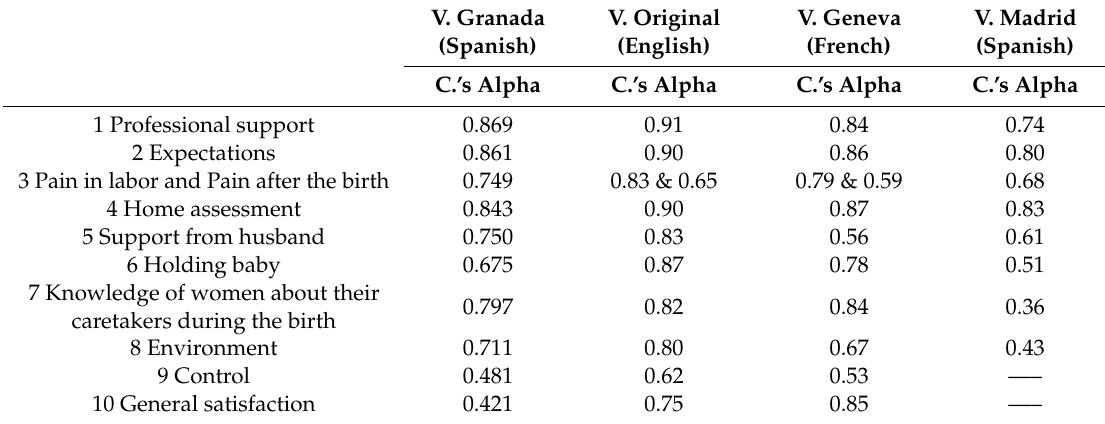
Table 4. Cronbach’s alpha values from the di ff erent studies analyzed.